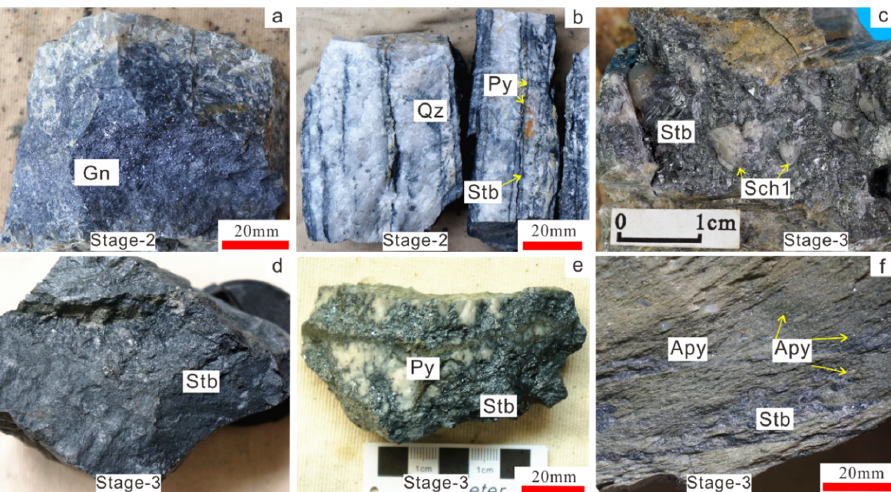
Figure 6. Representative photographs of samples selected for ore mineralogy. ( a ) Stage-2 galenite ore; ( b ) Stage-2 quartz-stibnite-pyrite ore containing coarse-grained pyrite; ( c ) Stage-3 coarse-grained Sch1 scheelite cemented by euhedral-subhedral stibnite; ( d ) Stage-3 high grade stibnite ore; ( e ) Stage-3 pyrite veinlet associated with stibnite; ( f ) Stage-4 arsenopyrite densely disseminated in the wallrock. Gn = galena; Qz = quartz; Py = pyrite; Stb = stibnite; Sch1 = scheelite type1; Apy = arsenopyrite.